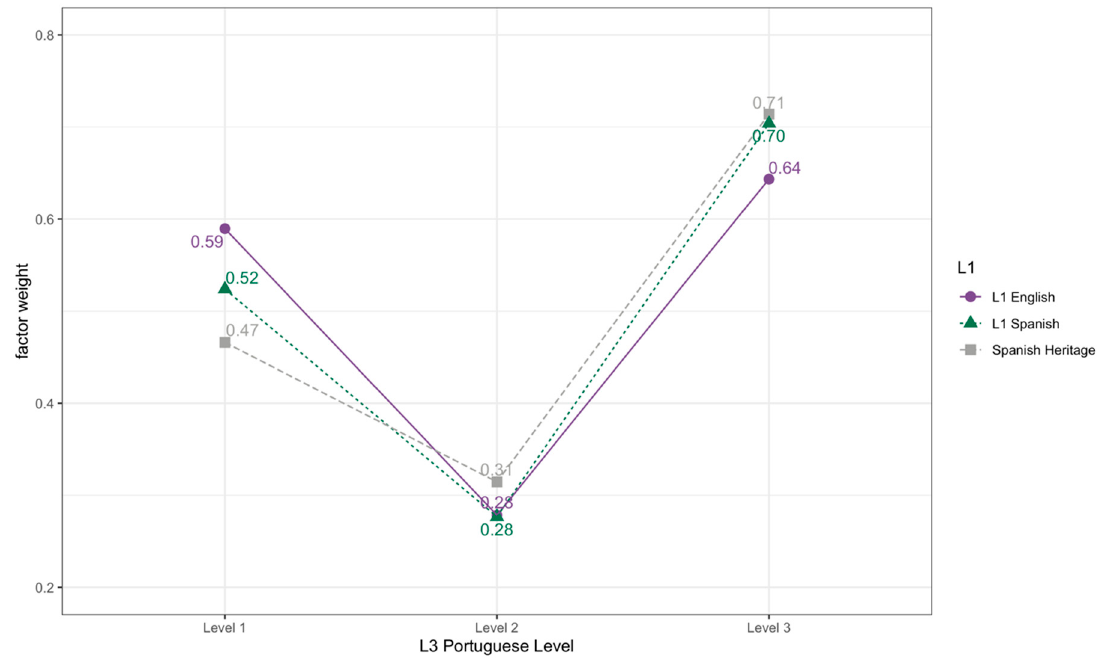
Figure 2. Factor weight (FW) across L3 Portuguese levels according to language background.